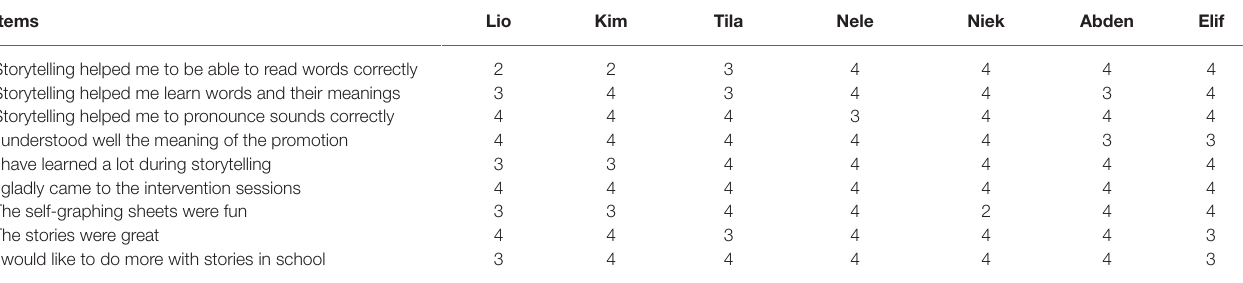
TABLE 11 | Results of social validity questionnaire. Items Lio Kim Tila